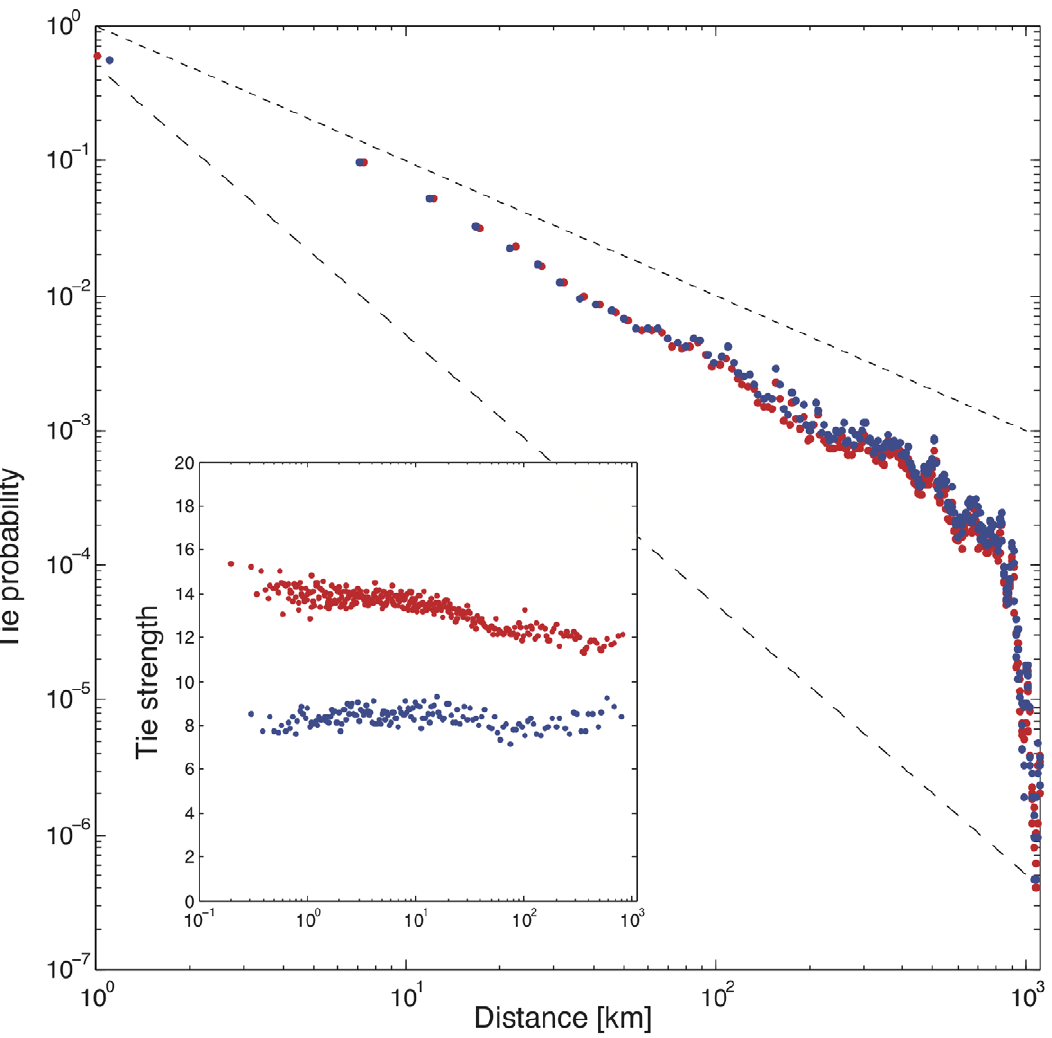
Figure 2. The probability of having a tie decreases as a function of distance. Two limiting cases, corresponding to exponents one and two, are shown as dashed lines. Note that if geography played no role, we would expect P ( d ) to be independent of distance d , resulting in a horizontal line in this plot. Inset: Tie strength, in contrast to the communication probability, is nearly flat with distance, although there is a minor decreasing trend for voice-ties.